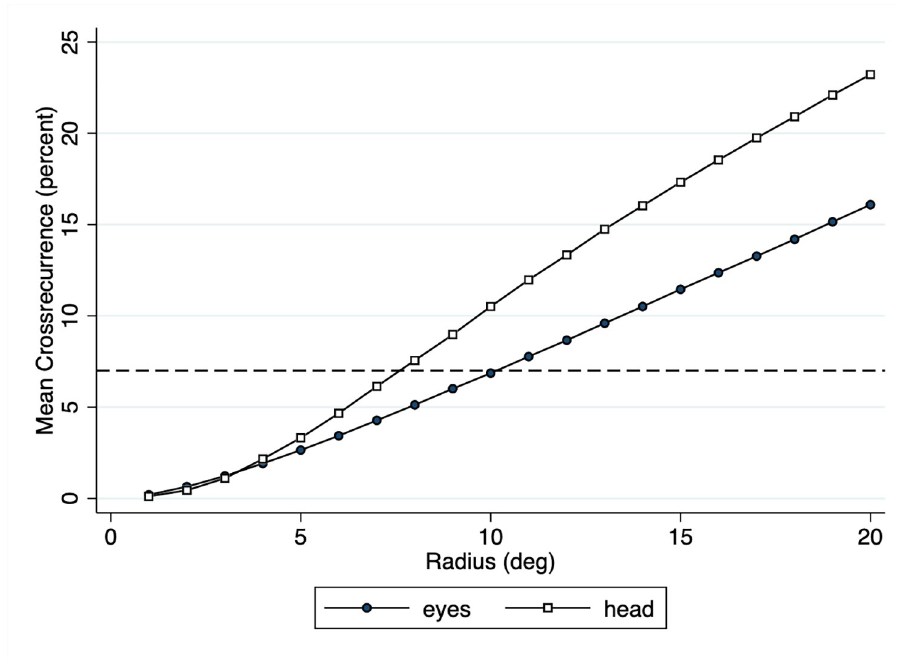
Fig 6. Mean cross-recurrence of eyes and head as a function of cross-recurrence radius. The cross-recurrences were computed for all panoramas used in the experiment. As the radius increases, so does the mean cross-recurrence. We chose a radius of 10.1˚ for fixations and 7.6˚ for average head positions to obtain an average cross-recurrence of 7 percent (dashed line).